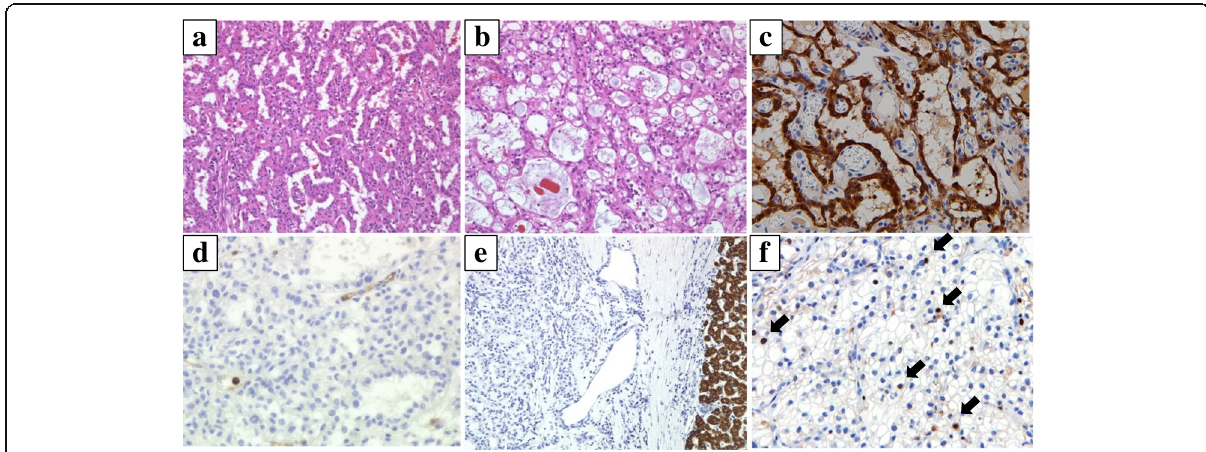
Fig. 4 Histological findings of tumors. a Histological specimen of liver tumor (hematoxylin and eosin (HE), ×200) shows epithelioid-type mesothelioma cells with tubular components. b Mesothelioma cells with cystic components (HE, ×200). c Immunohistochemical staining for calretinin shows positive tumor cells (×200). d Immunohistochemical staining for CEA shows negative tumor cells (×200). e Immunohistochemical staining for HepPer1 shows negative